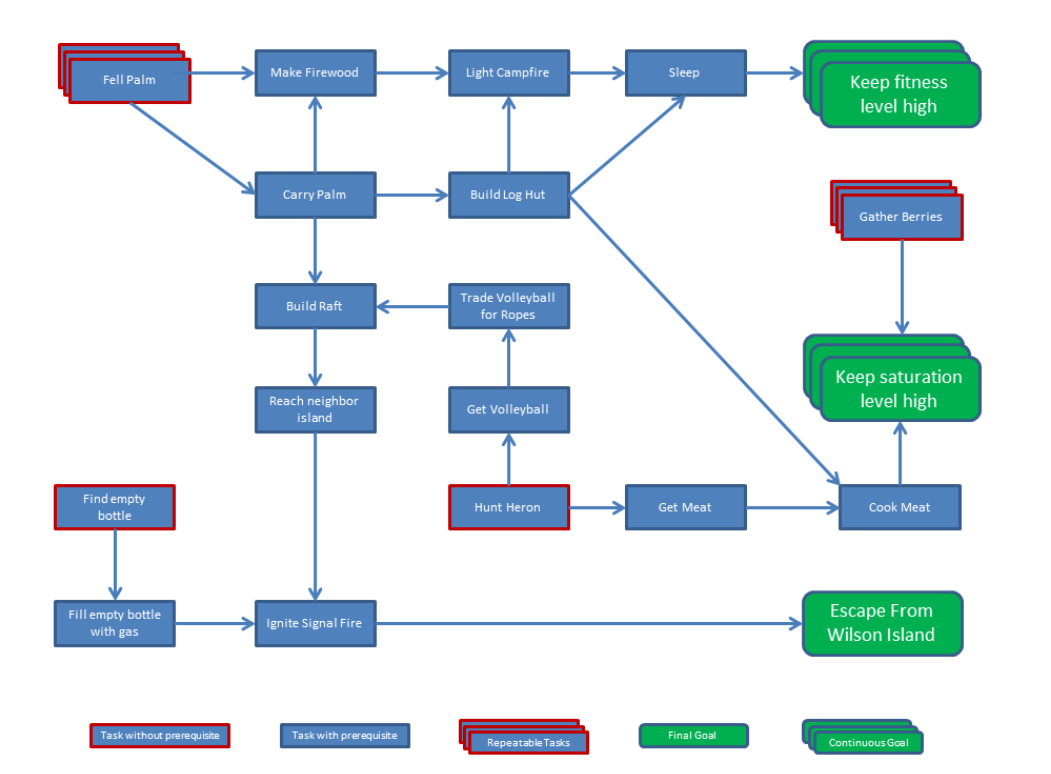
Figure 1. Schematic of all Escape From Wilson Island